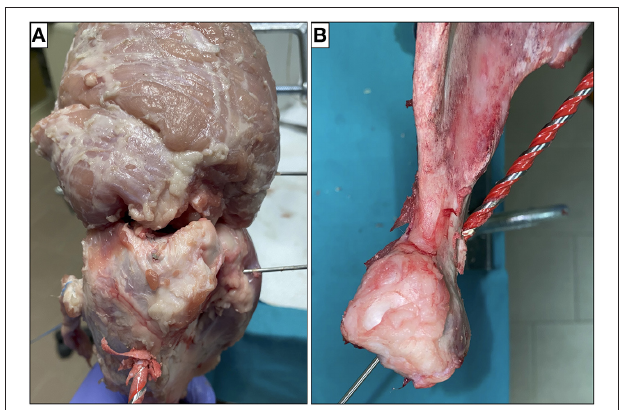
FIGURE 5 | The ligament was basted with absorbable wires (A) and passed through the two tunnels (B) .